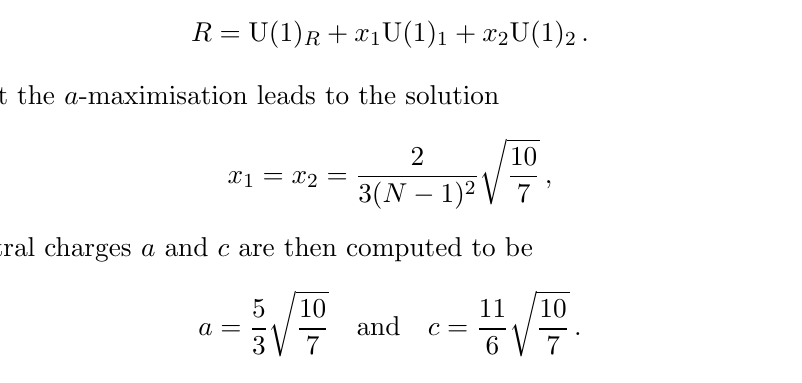
superpotential terms for the (anti-)symmetric matter (cid:12)elds. For example, the (cid:12)elds (cid:22) A (cid:22) S have superpotential as in (3.19), 2